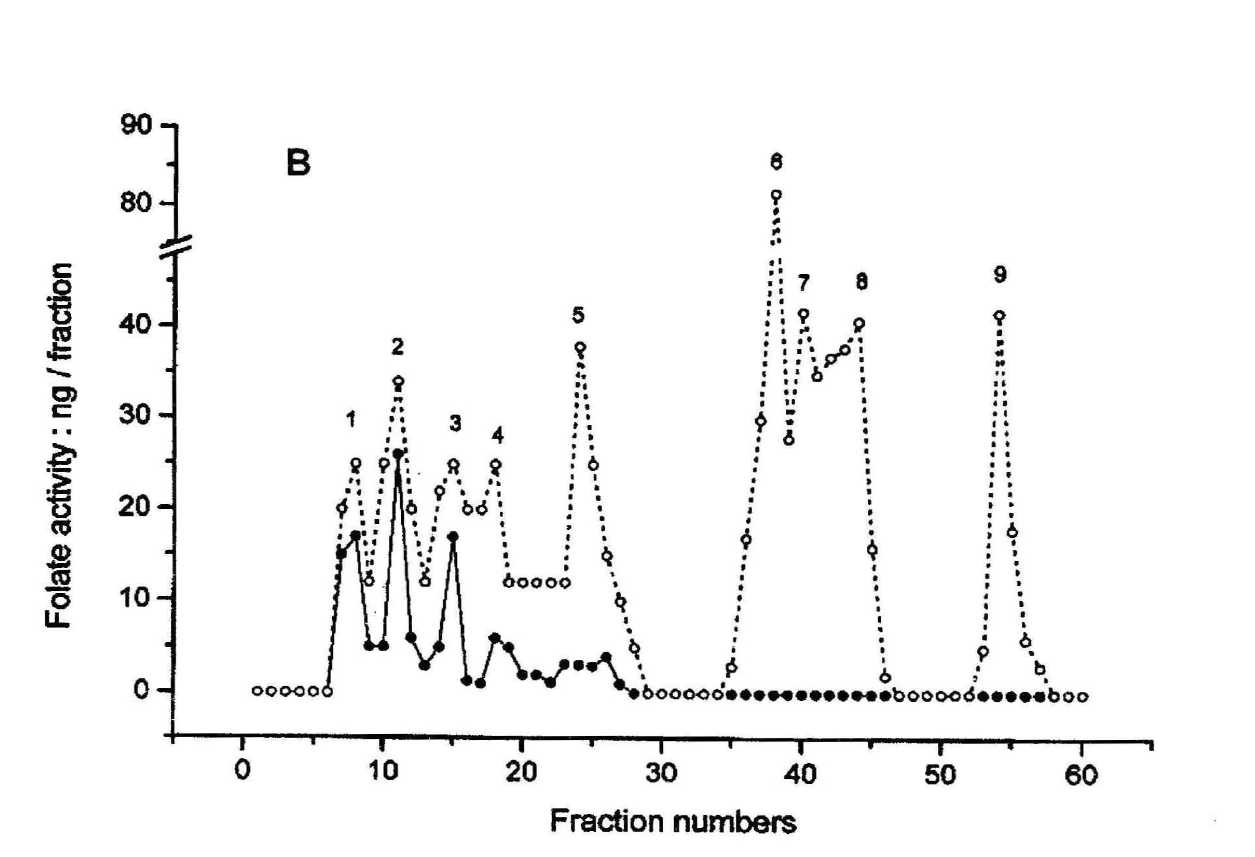
Figure 1. Analytical DEAE celluiose chromatogram of mouse liver extract. A, Control; B, Irradiated. About 0.5- 0.8 Ilg folate activity was adsorbed on to DEAE cellulose column and 0.1-0.5 M phosphate gradient elution was carried out as described in the text. Folate activity of 0.1 ml aliquots of each fraction was determined before and after chicken liver folyl conjugase digestion, as described in the text. L.casei activity before (-) and after (0- --0) conjugase treatment is shown in the figure. The folates analyzed for various fractions are computed as percentage of total folates and represented in Table 3.